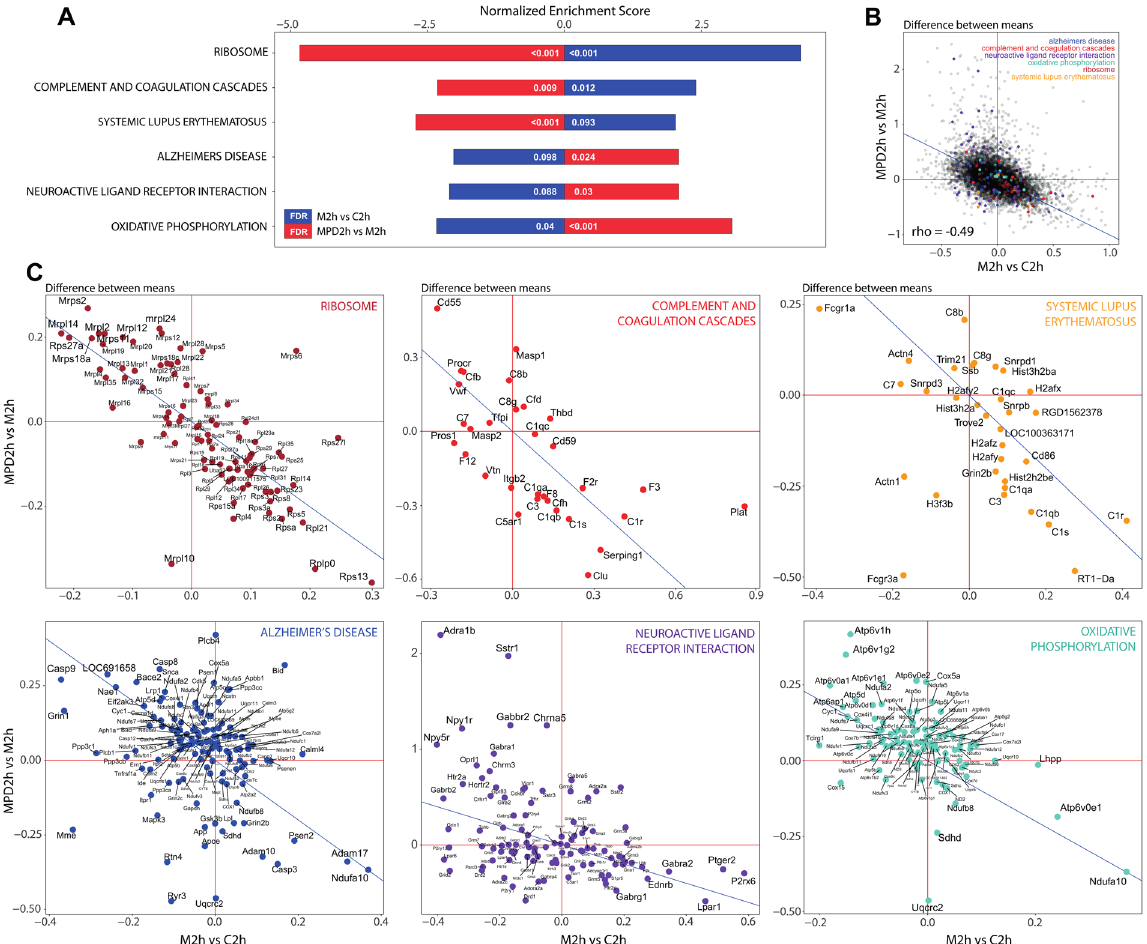
Figure 3. Pathways involved in the countereffect of PD. ( A ) Normalized Enrichment Scores and FDR values for the 6 KEGG pathways significantly enriched in the “M2h vs C2h” and “MPD2h vs M2h” comparisons in the opposite direction. ( B ) Scatterplot of the differences between the means in the “M2h vs C2h” and “MPD2h vs M2h” comparisons for all 19587 expressed genes. ( C ) Scatterplots of the difference between the means in the same two comparisons for the genes involved in the 6 enriched pathways. In all scatterplots, the blue line represents the “perfect countereffect” line (y = − x), that is, the line on which the genes would lie if the countereffect of the addition of PD would be perfect (for